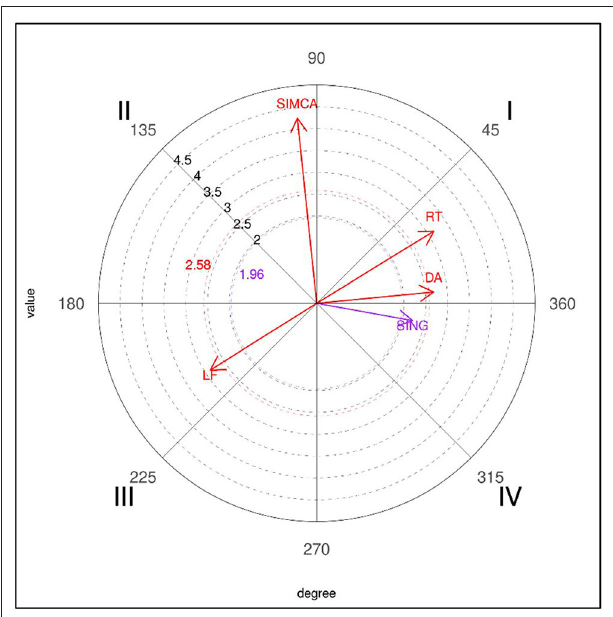
FIGURE 4 | Representation of the behavioral map for the 4P focal behavior in